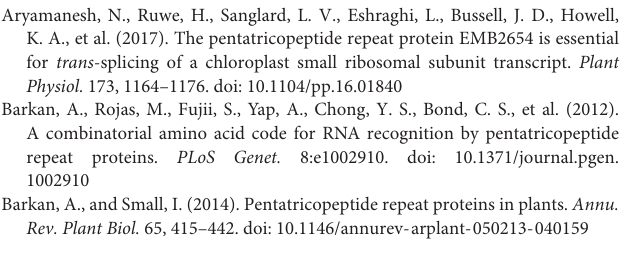
FIGURE S3 | Amino acid sequence alignment of WSL4 and its close homologs. Sequences are from Oryza sativa WSL4, Brachypodium distachyon XP_010235566.1, Hordeum vulgare BAK03057.1, Sorghum bicolo r XP_002452305.1, Sorghum bicolor KXG30467.1, Zea mays NP_001141010.1, Setaria italica XP_004952727.1, Setaria italica KQL30111.1, Aegilops tauschii EMT15761.1, and Arabidopsis thaliana NP_172461.1. FIGURE S4 | Quantitative RT-PCR analyses of genes related to chlorophyll biosynthesis in WT and the wsl4 mutant. RNA was extracted from L3-3 of WT and wsl4 mutant plants grown in a growth chamber under L30/D25. L3-3 indicates the third leaf at the three-leaf stage. Values are means ± SD of three replicates. (Student’s t -test: ∗ P < 0.05, ∗∗ P < 0.01). FIGURE S5 | RNA editing analyses of chloroplast genes in WT and wsl4 mutant. Arrowheads indicate editing sites and their positions in the corresponding chloroplast cDNA strand. RNA was extracted from L3-3 of WT and wsl4 mutant (white striped sector) plants grown in a growth chamber at L30/D25. L3-3 indicates the third leaf at the three-leaf stage. FIGURE S6 | Low temperature exacerbated splicing defects of atpF , ndhA , rpl2 , and rps12 transcripts in wsl4 mutant. qRT-PCR analyses of atpF , ndhA , rpl2 , and rps12 transcripts in L3-3 from WT and wsl4 mutant (white striped sectors) seedlings grown in a growth chamber with 12 h photoperiod at C30, L30/D25, and C20. L3-3 indicates the third leaf at the three-leaf stage. Histograms show log2 ratios of spliced to unspliced RNA in wsl4 compared to WT. Values are means ± SD of three replicates. (Student’s t -test: ∗ P < 0.05, ∗∗ P <